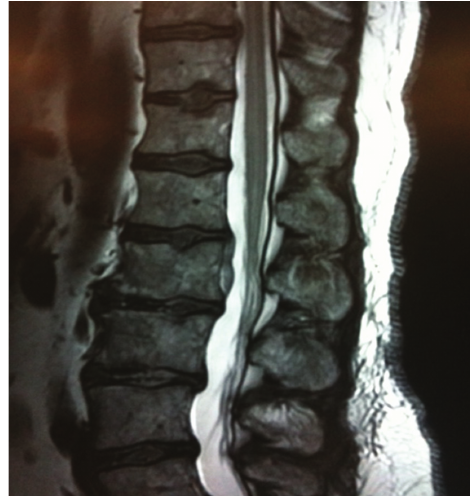
Figure 2: MRI of the lumbar spine showing acute spinal cord in- farction. Sagittal T2-weighted MRI of the patient’s lumbar spine showing a nonspecific central intrinsic signal hyperintensity of the spinal cord located in conus region with extension to T8 level. Image also shows multilevel degenerative disc disease with noncompres- sive disc herniation at L1-L2.